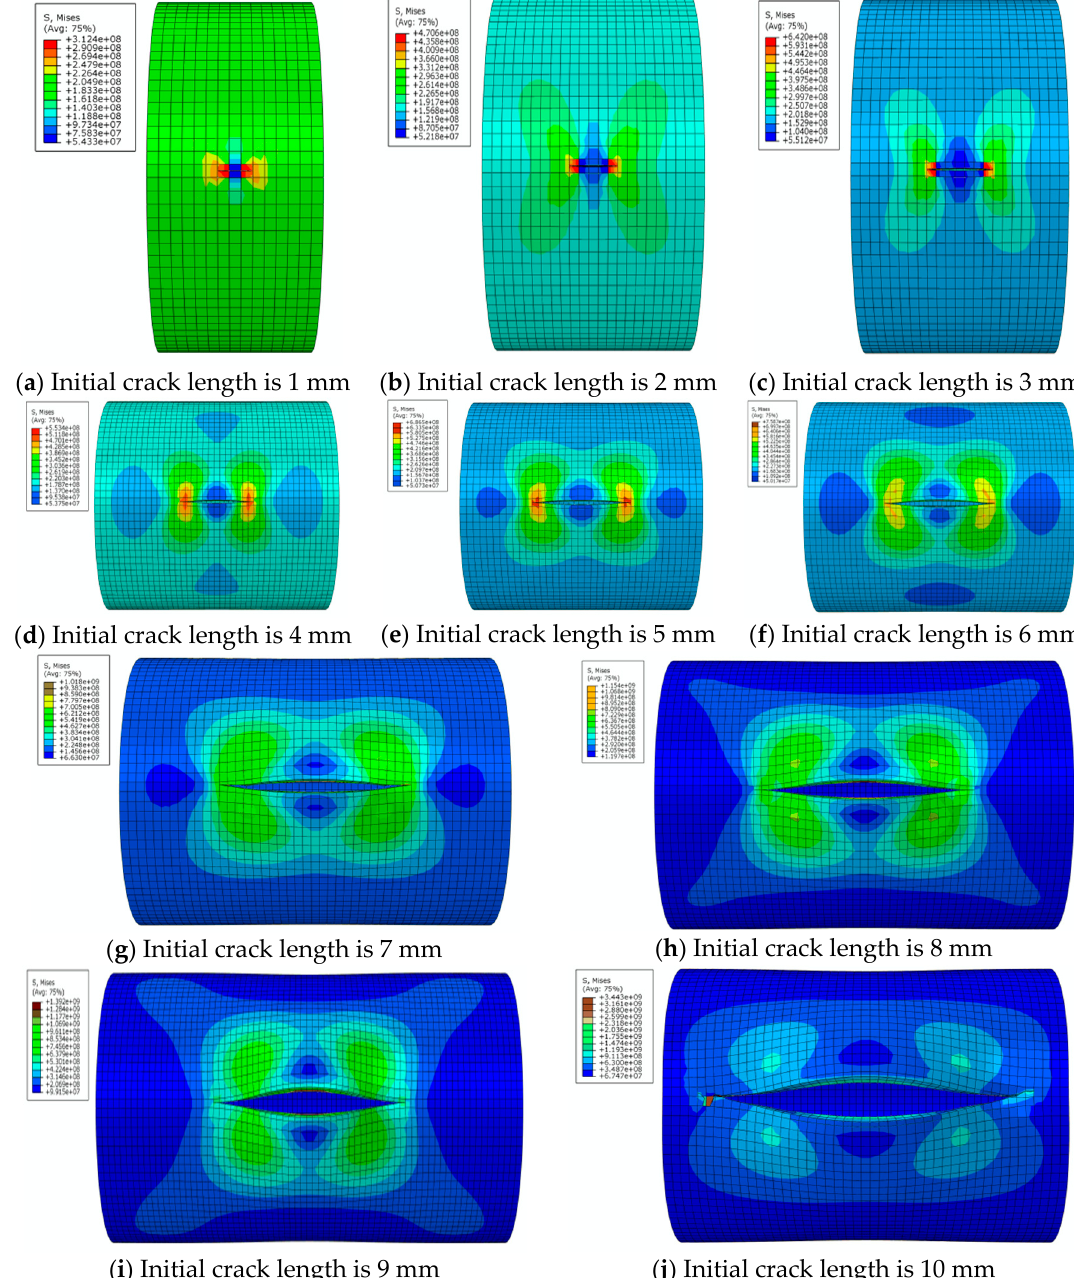
Figure 8. The von Mises stress distribution for different initial crack lengths, where the internal pressure is 21 MPa (here, images are magnified 10 times for visual display).